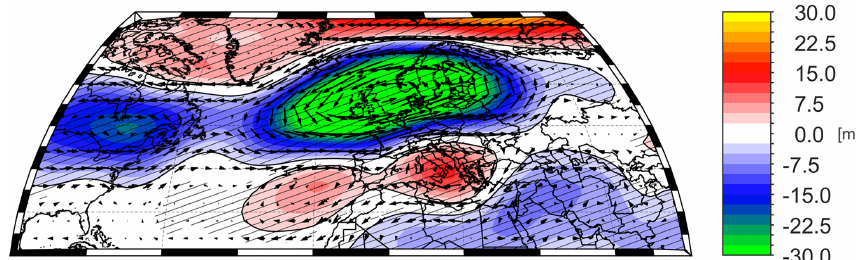
Figure 9. Composite map (high − low) for Z500 related to the second δ 18 O component (PC2) for the boreal summer. The Z500 dataset from 20CRv2c (Compo et al., 2011) is used in this figure for the period from 1901 to 2005. Furthermore, the significance is shown using a black contour